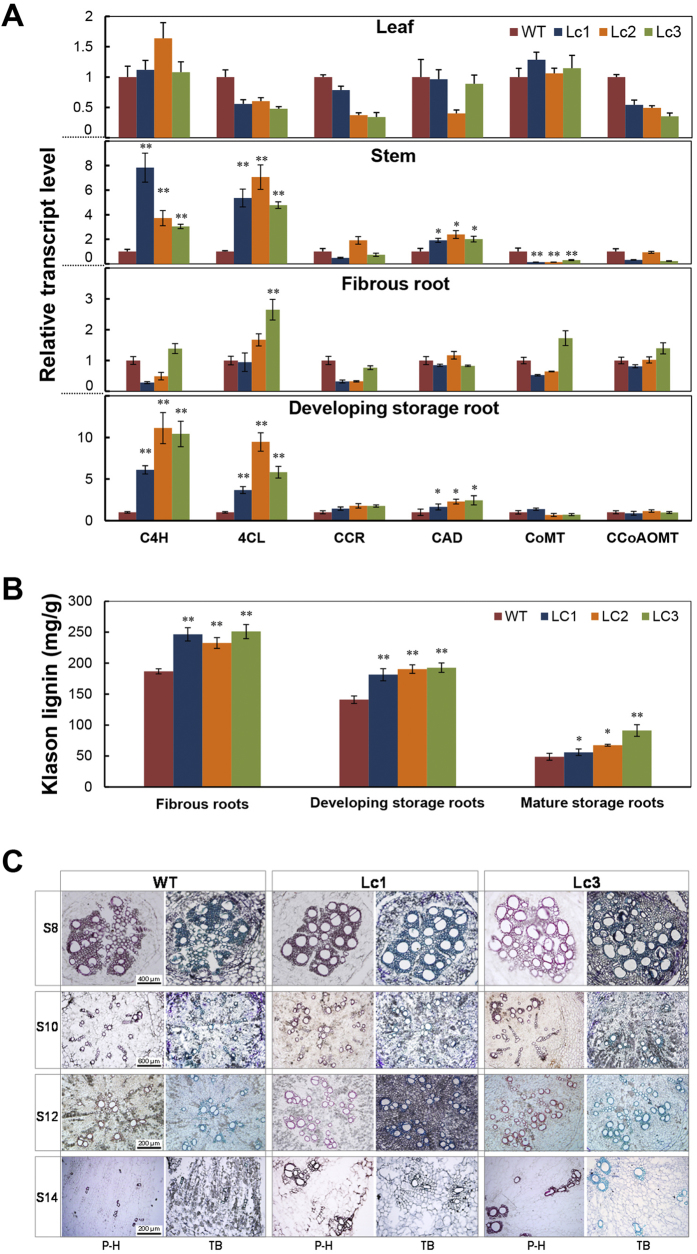
Effect of Lc expression on lignin biosynthesis and deposition in wild-type and Lc transgenic sweet potato.(A) qRT-PCR analysis of the changes in the transcript levels of major lignin biosynthetic genes in the leaves, stems, fibrous roots (S5-S8) and developing storage roots (S16) of 2-month-old wild-type (WT) and Lc transgenic sweet potato. Lc1–3, independent Lc transgenic lines. C4H, cinnamic acid 4-hydroxylase; 4CL, 4-coumarate-CoA ligase; CCoAOMT, caffeoyl-CoA O-methyltransferase; CCR, hydroxycinnamoyl-CoA reductase; CAD, cinnamyl alcohol dehydrogenase; COMT, caffeic acid/5-hydroxyferulic acid O-methyltransferase. (B) Klason lignin contents in the fibrous roots (S5-S8), developing storage roots (S10) and mature storage roots (>S18) of 5-month-old field-grown sweet potato plants. (C) Lignin deposition patterns in the initiating storage roots (S8), early developing storage roots (S10 and S12) and late developing storage roots (S14) of 1.5-month-old plants after staining with two dyes, phloroglucinol-HCl (P-H) and toluidine blue (TB). Error bars represent the SE of three independent replicates. Asterisks indicate a significant difference compared to the WT at *P < 0.05 or **P < 0.01 (t-test).